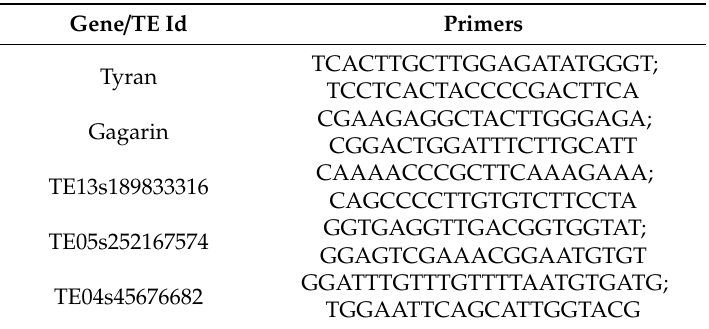
Table 4. Primers for eccDNA amplification.